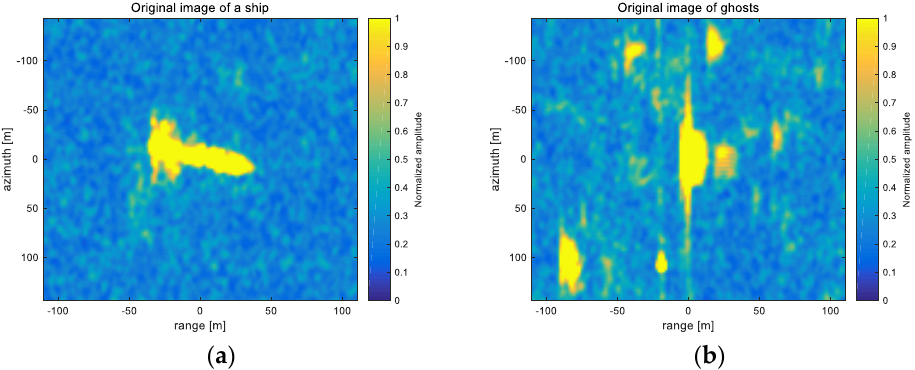
Figure 3. Sub-sampled amplitude images of a typical ( a ) ship and ( b ) ghosts. The sample size of the two areas was 129 by 129 in terms of the range and azimuth, respectively. Both images were normalized by a common value pertaining to 96% of the statistical distribution of the amplitude over the whole area in Figure 2.